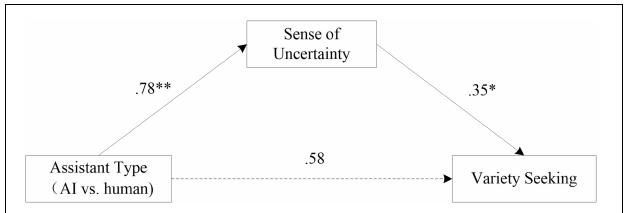
FIGURE 2 | Mediation model in study 2. ∗∗ Significant at the 0.01 level; ∗ significant at the 0.05